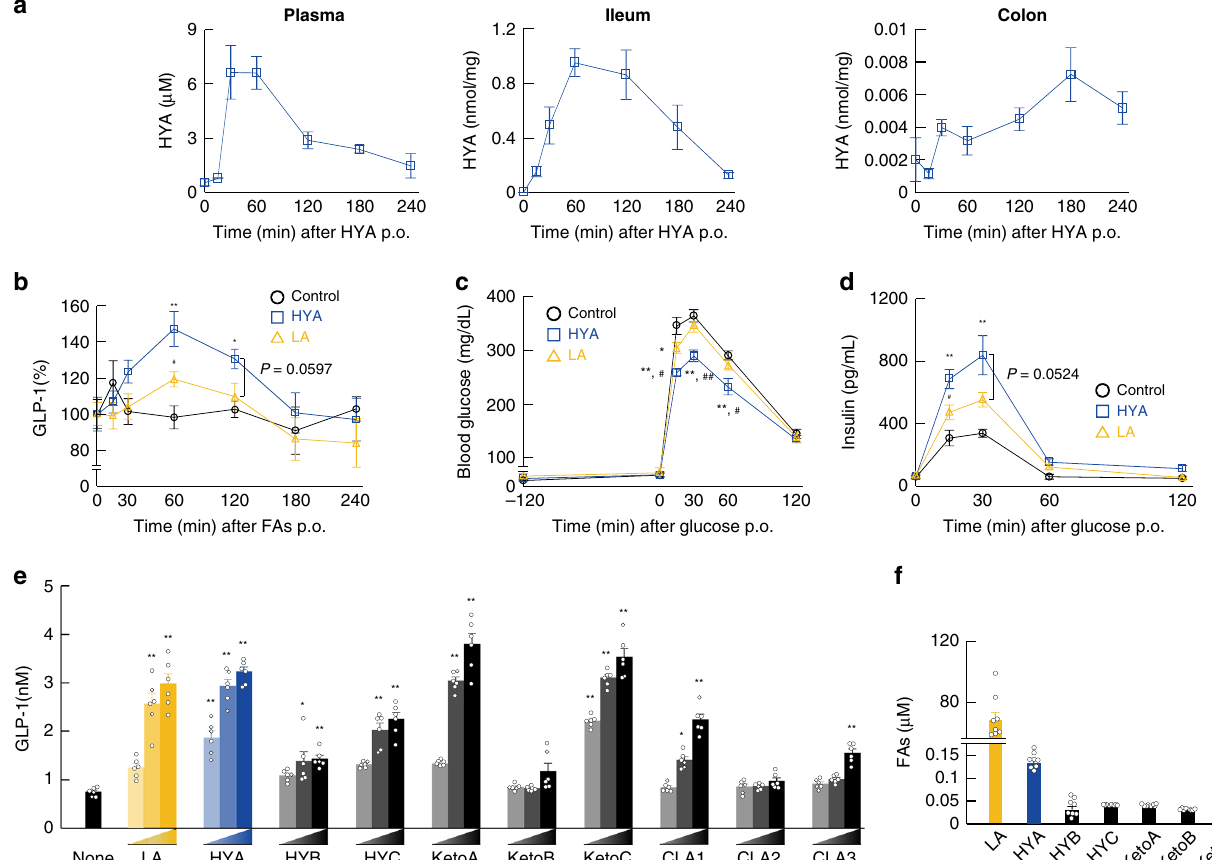
Fig. 5 HYA directly regulates glucose homeostasis and GLP-1 release. Individual FAs (HYA and LA; 1 g/kg) were administered by gavage, followed by a HYA quanti fi cation in plasma (left), ileum (center), and colon (right) ( n = 8 animals). b Time-course changes in plasma GLP-1 from the tail vein was measured after oral administration of FAs ( n = 7 animals per group). Basal GLP-1 concentration at time 0 was set as 100%. c OGTT was analyzed 2 h after individual FA administration (HYA and LA; 1 g/kg) by gavage ( n = 8 animals per group). d Individual FAs were administered, and 2 h later, time-course changes in plasma insulin from the tail vein were measured after oral administration of glucose ( n = 8 animals per group). ** P < 0.01; * P < 0.05 vs. control (Tukey – Kramer test). ## P < 0.01; # P < 0.05 vs. HYA (Tukey – Kramer test). Results are presented as means ± SE. e STC-1 cells were treated with